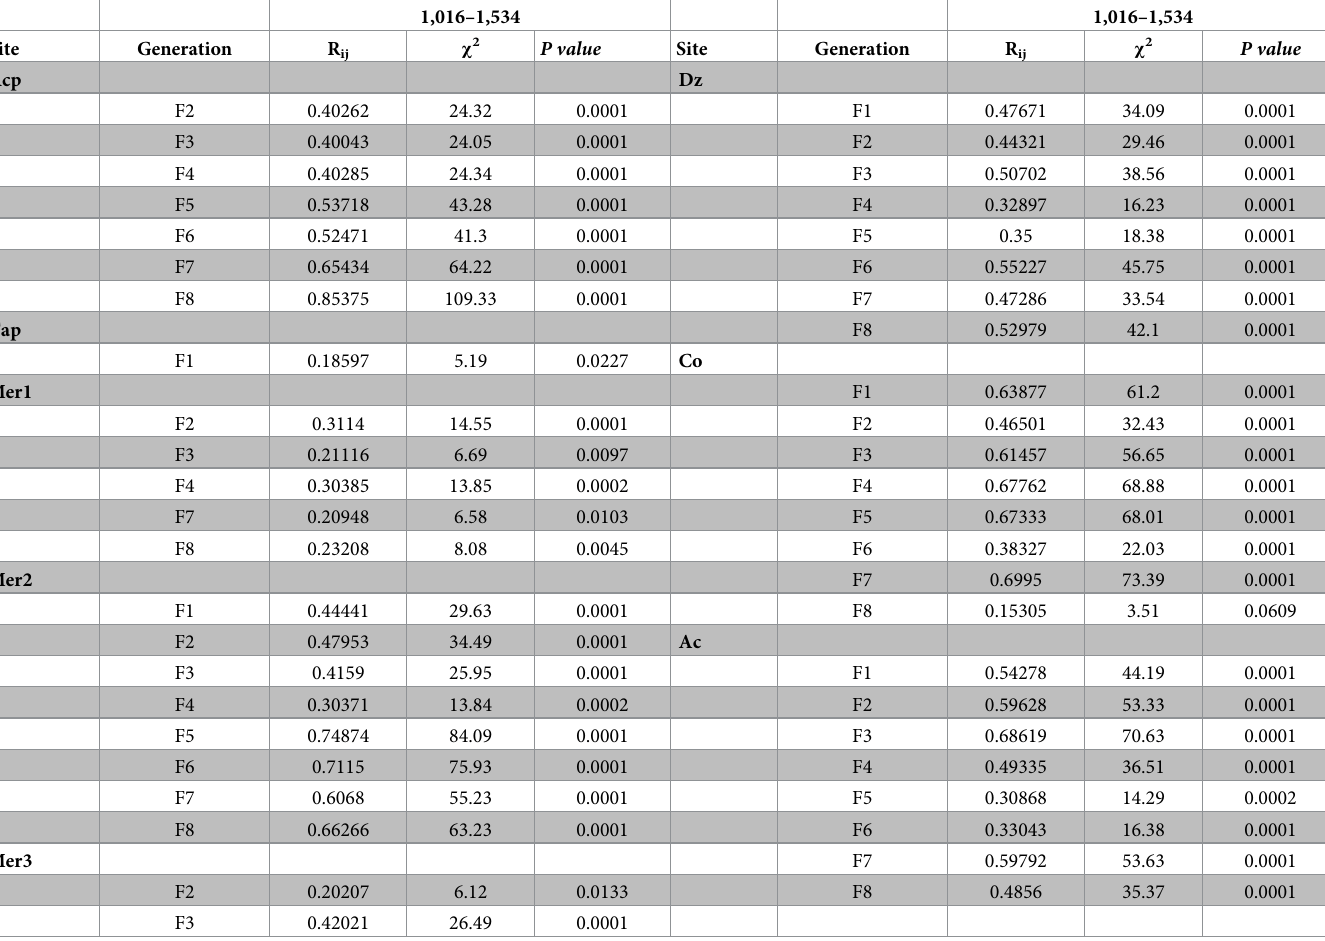
Table 4. Linkage disequilibrium coefficients between loci 1,016 and 1,534 over eight generations in absence of